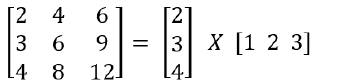
Figure 4. Splitting a 3 × 3 kernel spatially.